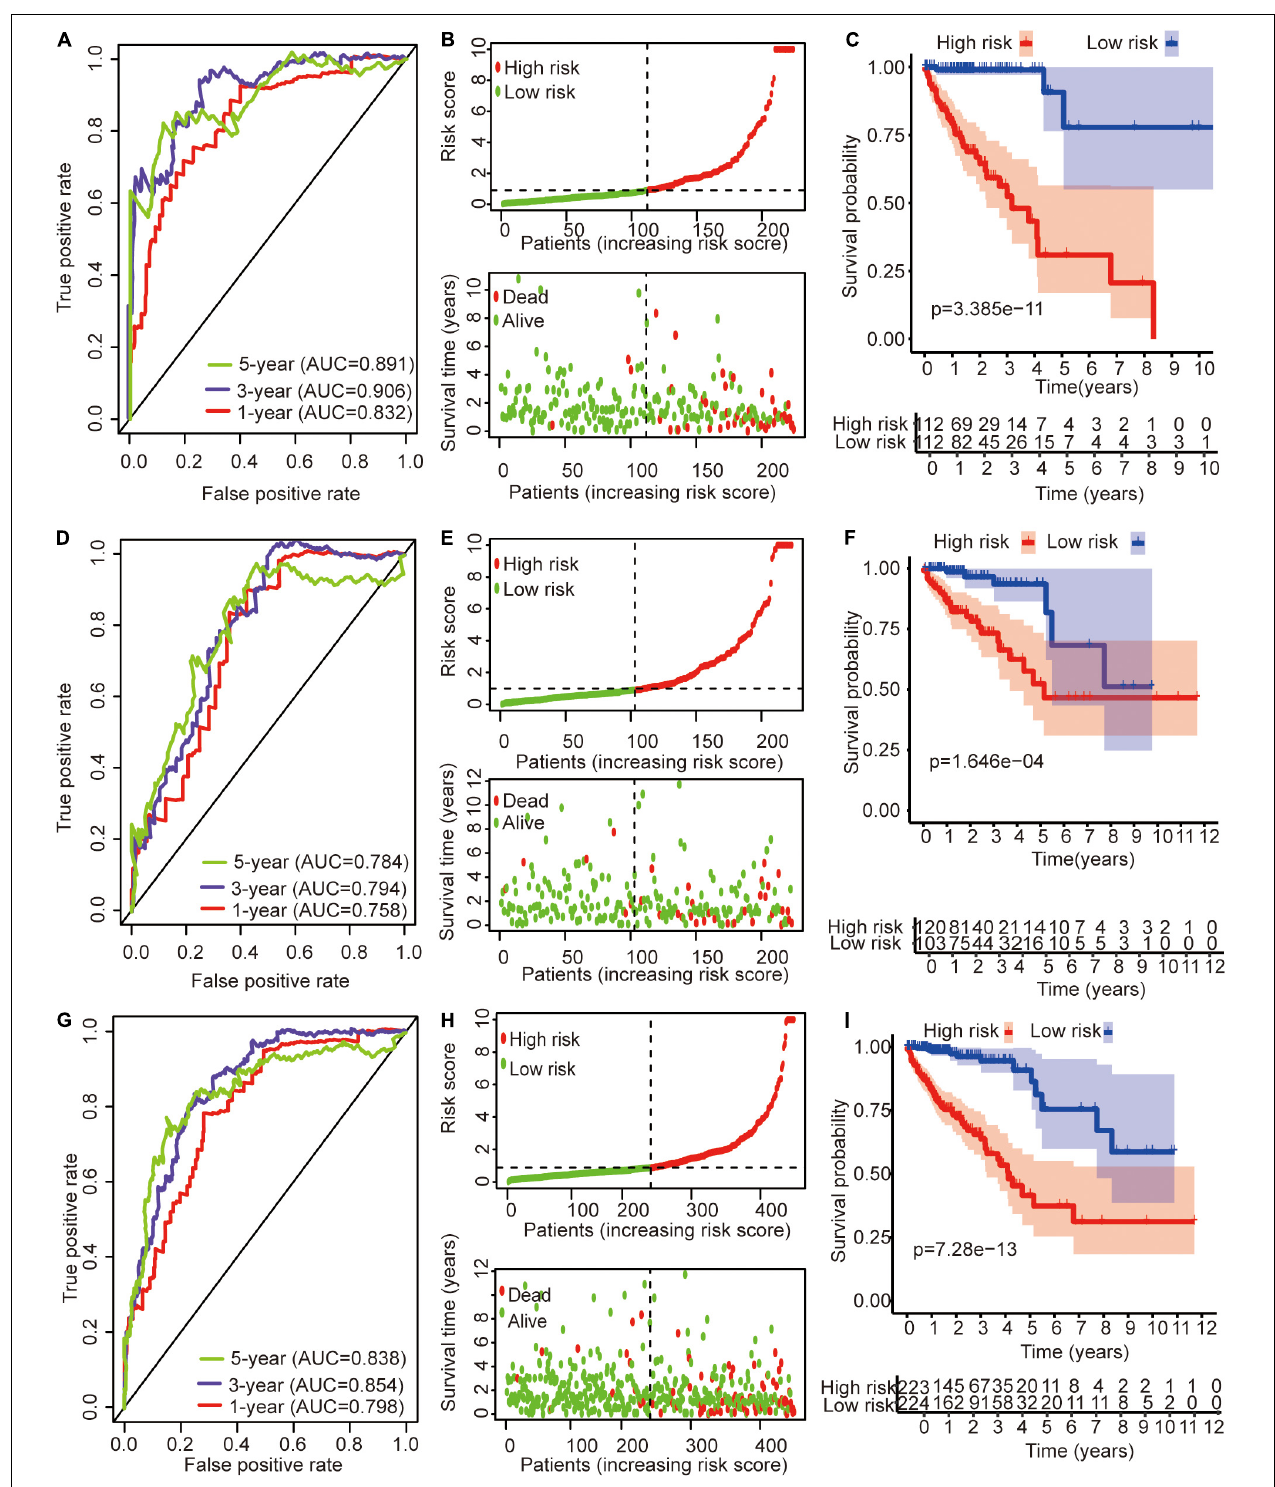
FIGURE 2 | Time–ROC curve analysis, risk score analysis, and Kaplan–Meier curve survival analysis of the immune-related lncRNA signature in colon cancer. (A) Time–ROC curve analysis, (B) risk score, and (C) Kaplan–Meier survival curve of the immune-related lncRNA signature in the training cohort. (D) Time–ROC curve analysis, (E) risk score, and (F) Kaplan–Meier survival curve of the immune-related lncRNA signature in the testing cohort. (G) Time–ROC curve analysis, (H) risk score, and (I) Kaplan–Meier survival curve of the immune-related lncRNA signature in the entire TCGA cohort.